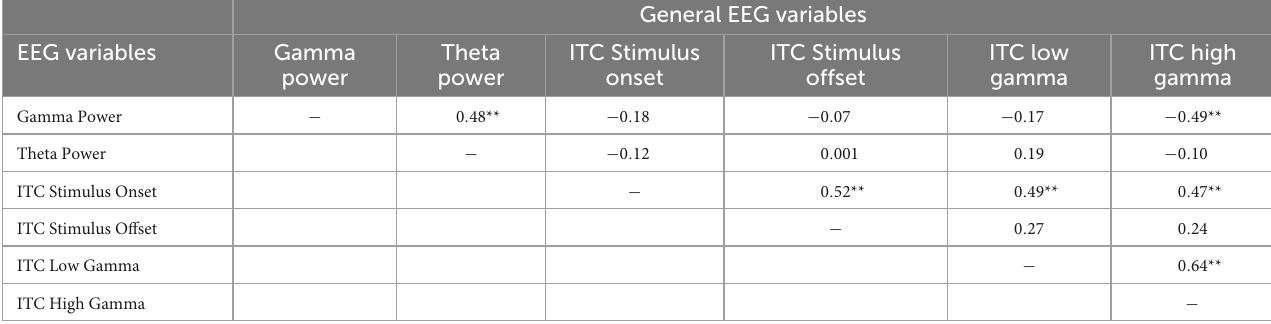
TABLE 5 Correlations between General EEG Variables for